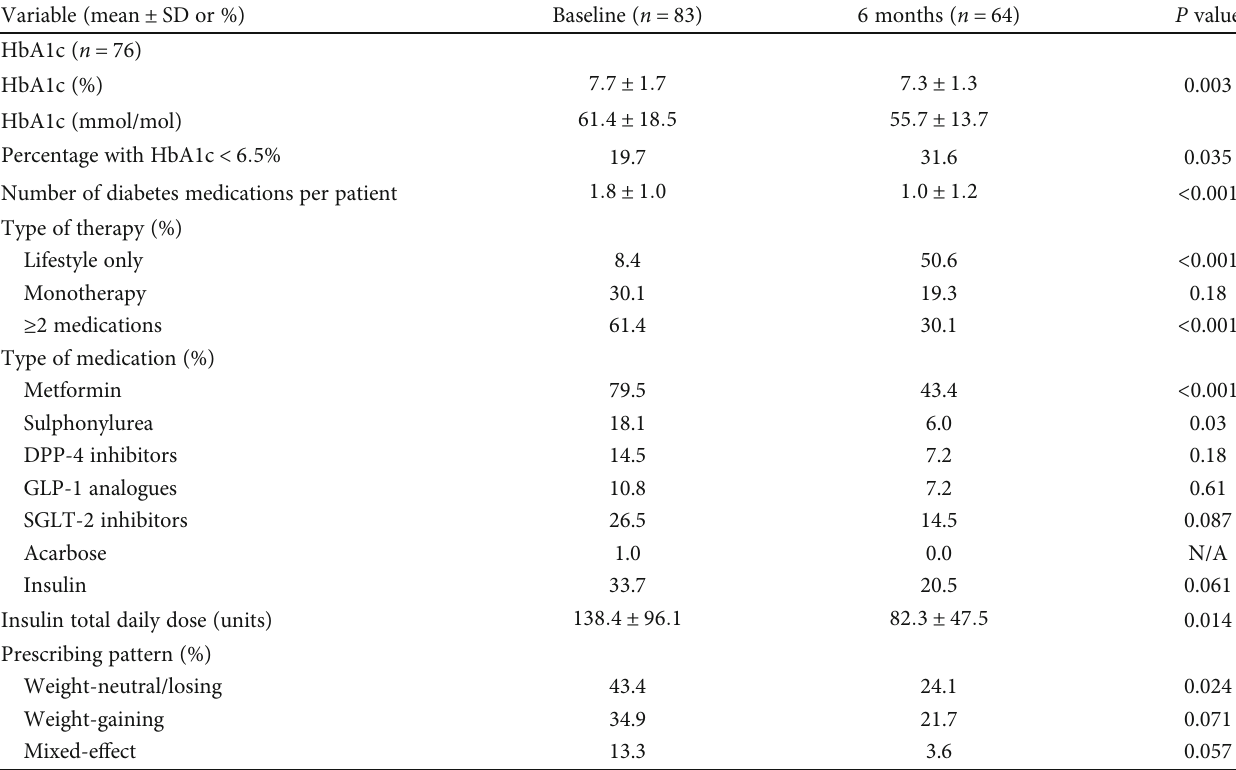
Table 2: Glycaemic control and diabetes medications at 6 months, for patients who had T2DM at baseline. Variable ( mean ± SD or